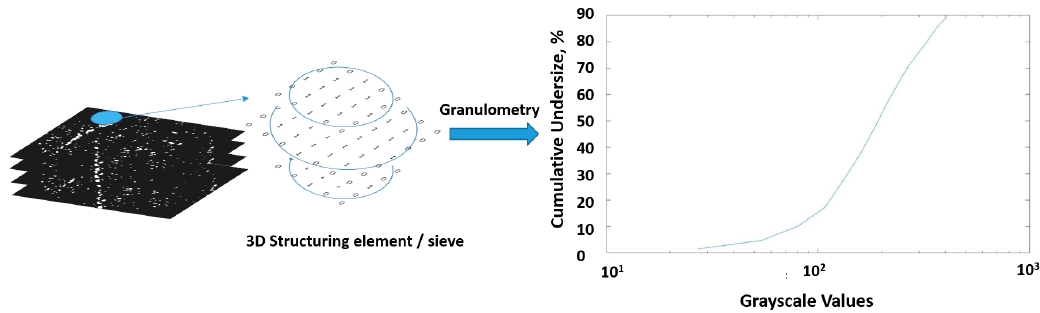
Figure 10. Granulometry by opening. A structuring element/sieve is operated on the stack of binary images, in which here represents the mineral grains in the ore sample. After operation, the grains smaller than the sieve are removed. The sieve size is then increased, and the distribution of the grains based on their sieve passing size is plotted. The structuring element in here is a stack of 2D structuring elements, mimicking a 3D structuring